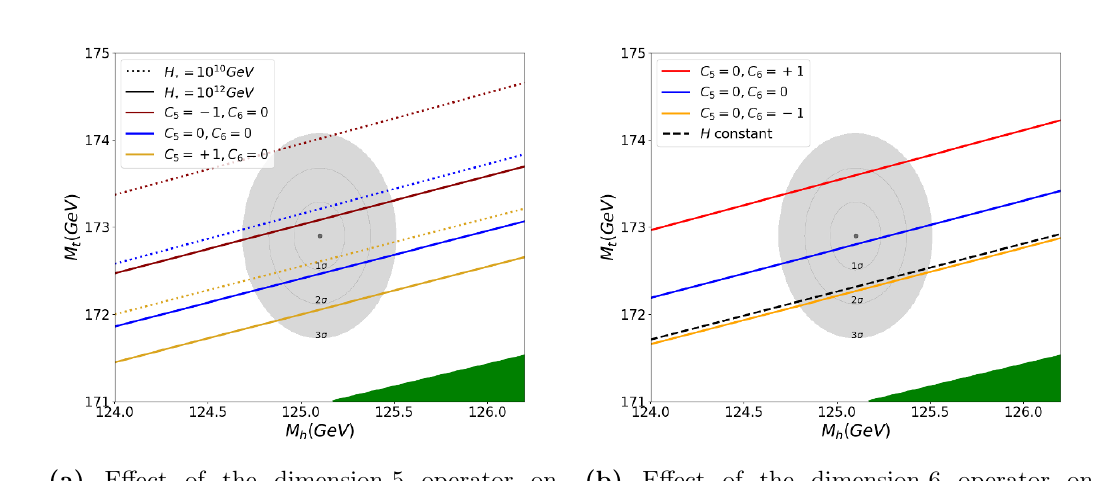
(a) E(cid:11)ect of the dimension-5 operator on (b) E(cid:11)ect of the dimension-6 operator on Starobinsky-like models. quartic-like models for H = 10 12 GeV. Figure 7. Bounds on the top/Higgs masses from the energy scale of in(cid:13)ation for (cid:24) = (cid:0) 0 : 05, (cid:11) s = 0 : 1181 and T RH . 10 4 GeV (equivalent to demanding no Hubble patch with j h j > h max at the end of in(cid:13)ation), for di(cid:11)erent setups listed in the legend. Any given scenario marks a line separating the excluded region in parameter space (above) from the allowed one (below). In green, the stability region where the quartic Higgs coupling stays positive up to the Planck scale. The dashed black line on the right plot stays for the benchmark analysis done assuming H = 10 12 GeV = const and f